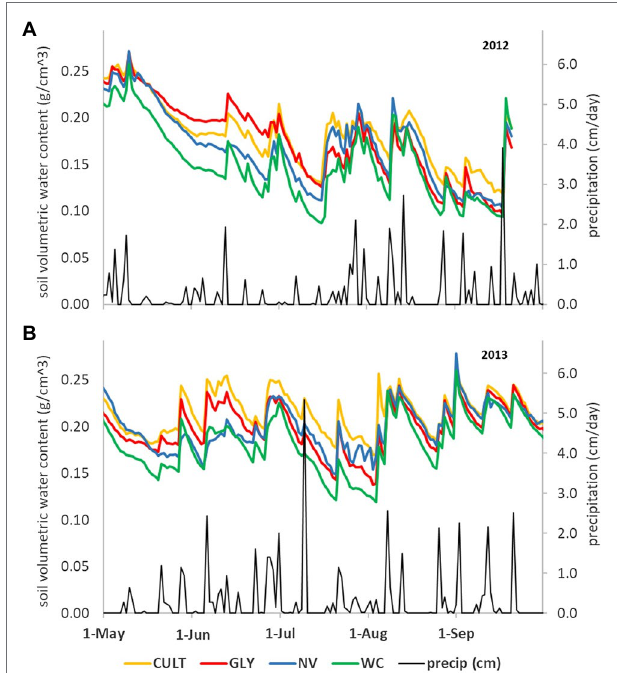
FIGURE 3 | Soil water content (g/cm 3 ) measured at midday under four UVV treatments in Lansing, NY, United States in (A) 2012 and (B) 2013 measured at 20 cm soil depth. CULT, cultivation; GLY, glyphosate; NV, natural vegetation; and WC, white clover. Data from Karl (2015), partially reported in Karl et al.